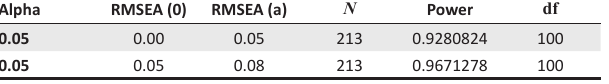
TABLE 6: Power assessment for the structural model for the tests of exact and close fit. Alpha